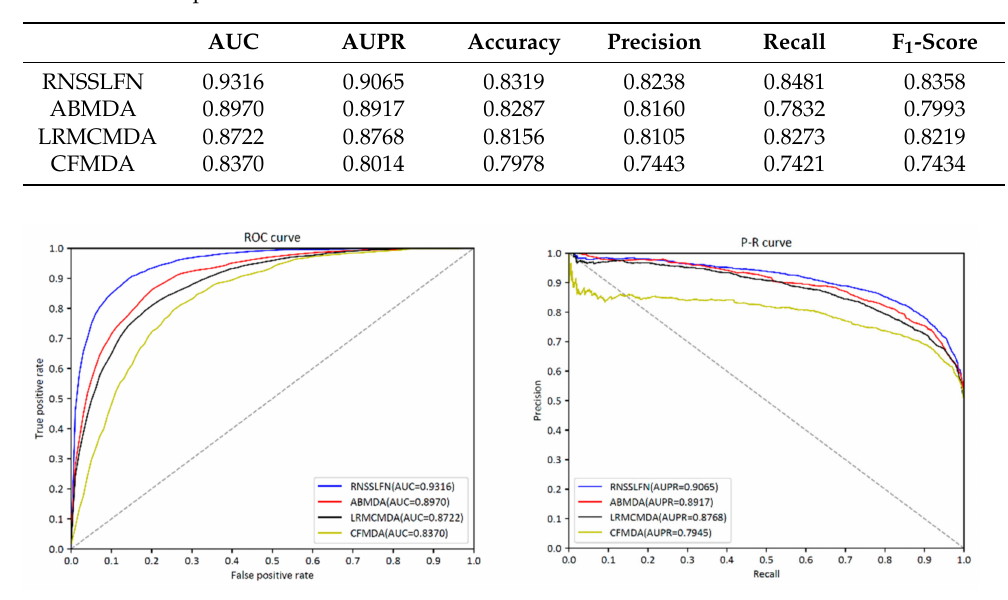
Table 1. The comparison results of four models under different evaluation indexes.